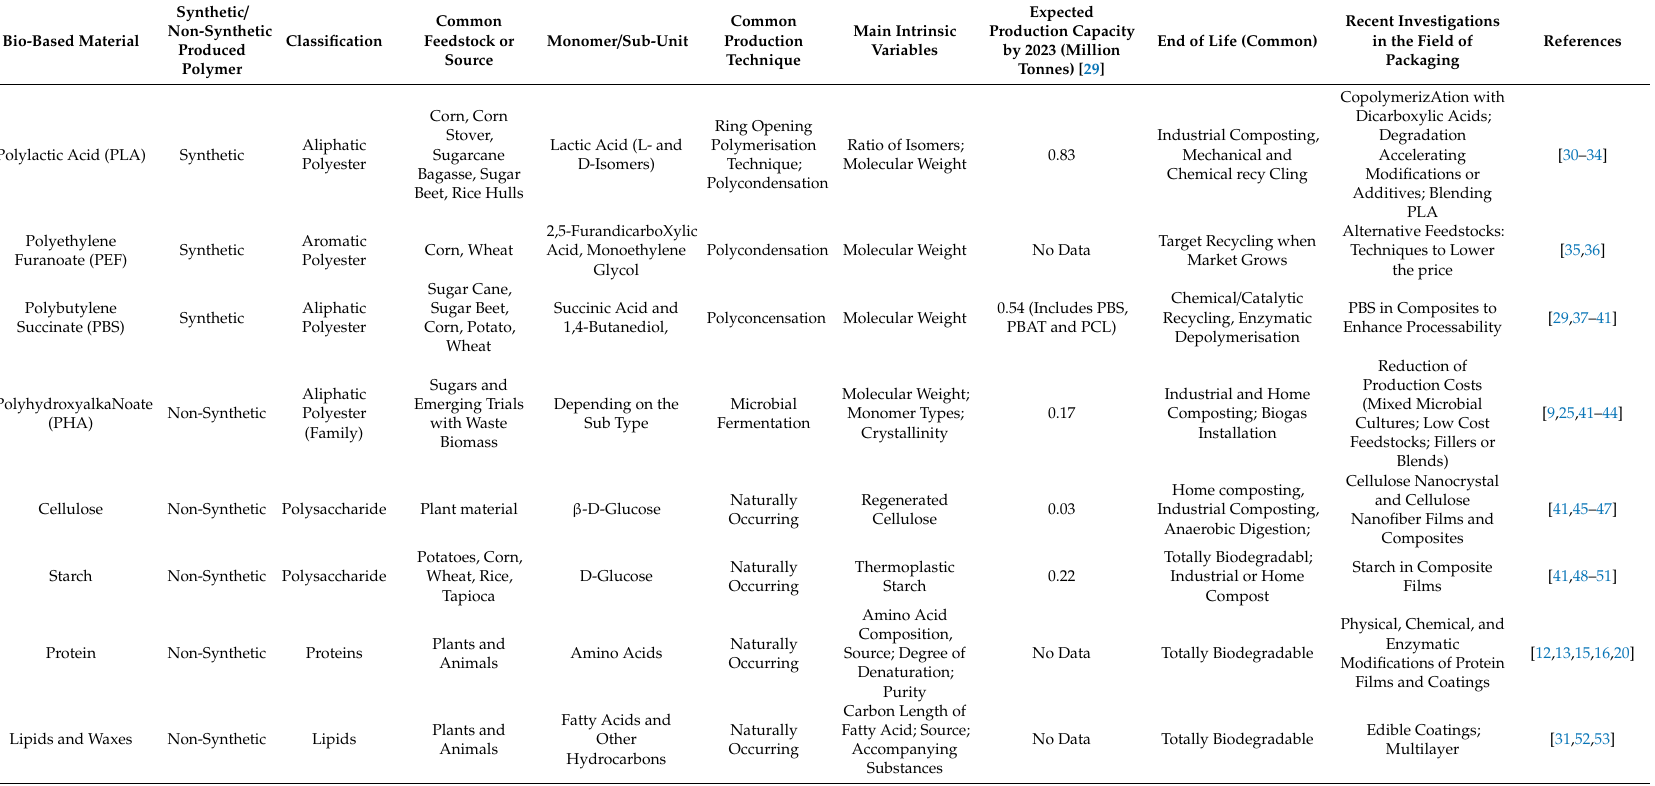
Table 1. Summary of the main characteristics of bio-based materials for packaging and textile